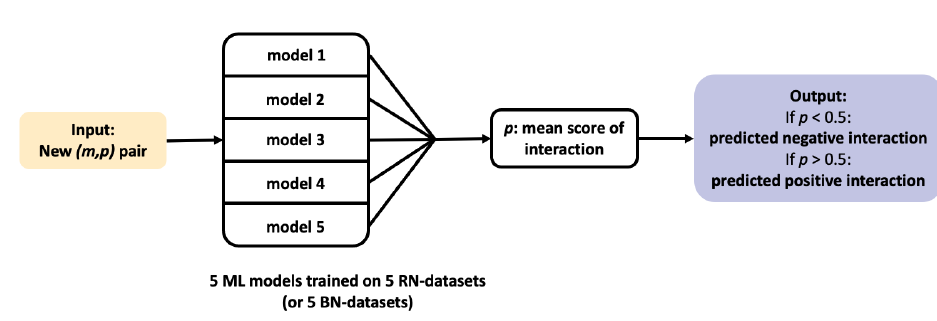
Figure 2. Flowchart of the Drug-Target Interaction (DTI) prediction pipeline.